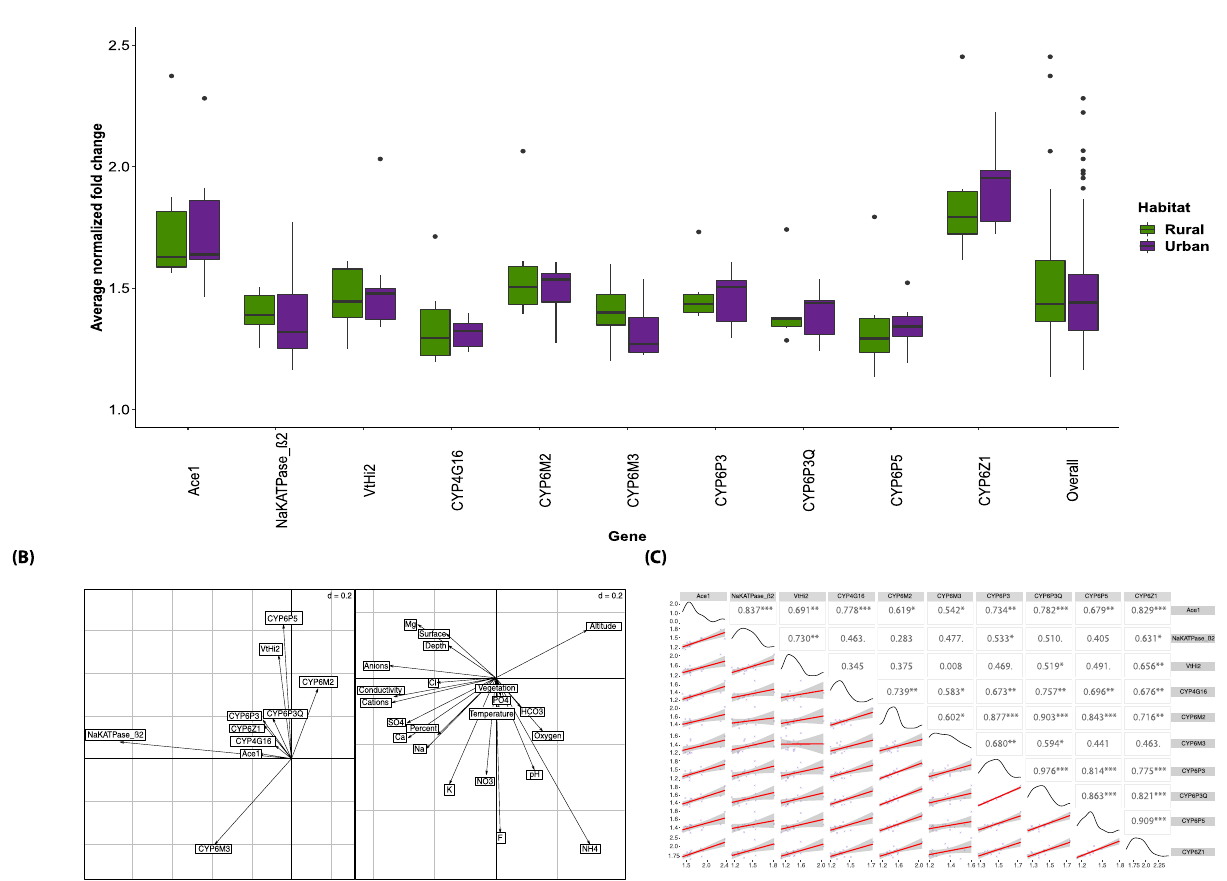
Figure 4. Correlation between gene expression profiles, habitat (rural and urban) and environmental predictors. ( A ) Association between habitat type and expression for each gene. ( B ) Coinertia diagram between gene expression on the left, and environmental predictors on the right. ( C ) Correlogram between genes (“number” = correlation coefficients; significance code 0’***’, 0.001’**’, 0.01’*’, 0.05’.’ and 0.1’ ’; each blue cross (*) corresponds to a